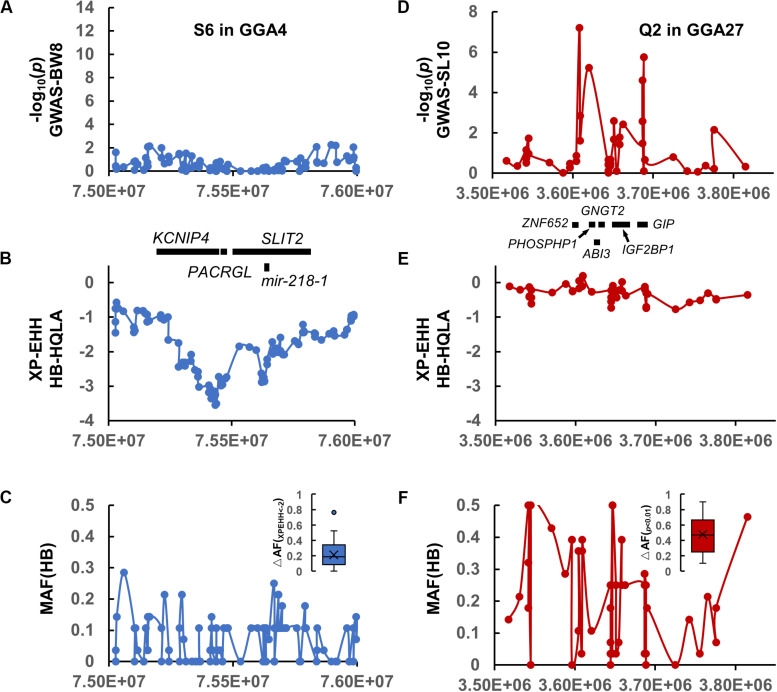
Comparison of the selection interval S6 in (A–C) and the QTL interval Q2 in (D–F). (A,D) The association results of S6 on GGA4 and Q2 on GGA27 with the genes displayed below. (B,E) The XP-EHH signature of S6 and Q2. (C,F) The MAF distribution for HB and the allele-frequency differences between the HQLA and HB (ΔAF) in S6 and Q2, respectively.